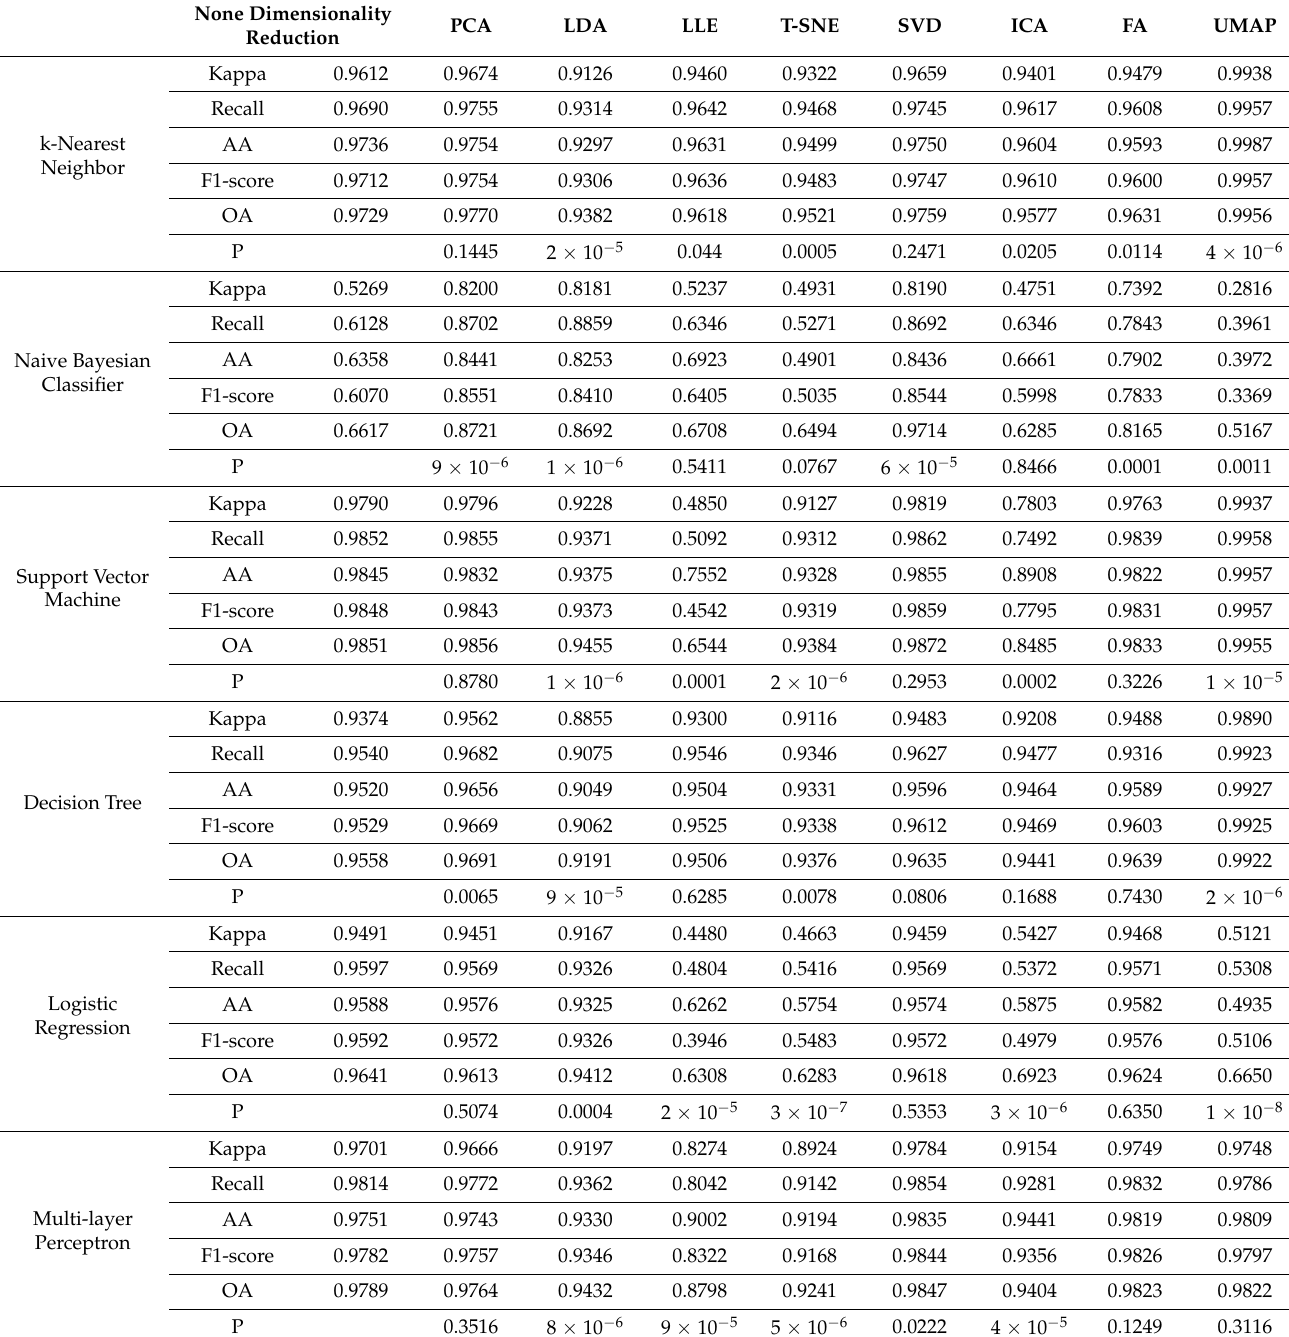
Table 4. Classification accuracy of hyperspectral images with different dimensionality reduction classification